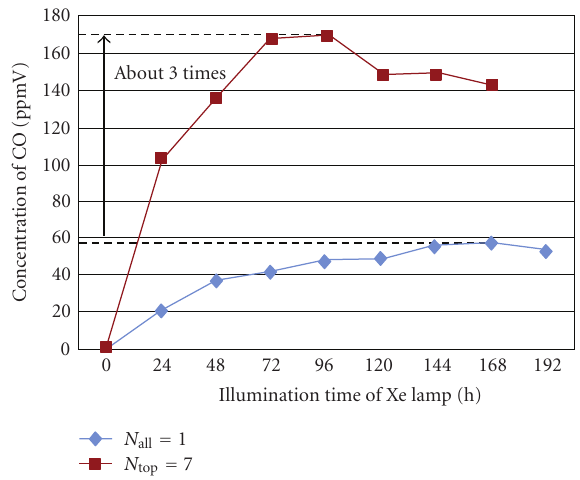
Figure 11: Comparison of concentration change of CO by CO 2 reforming with illumination time of Xe lamp without UV light of 72 hours for N all = 1 and N top =